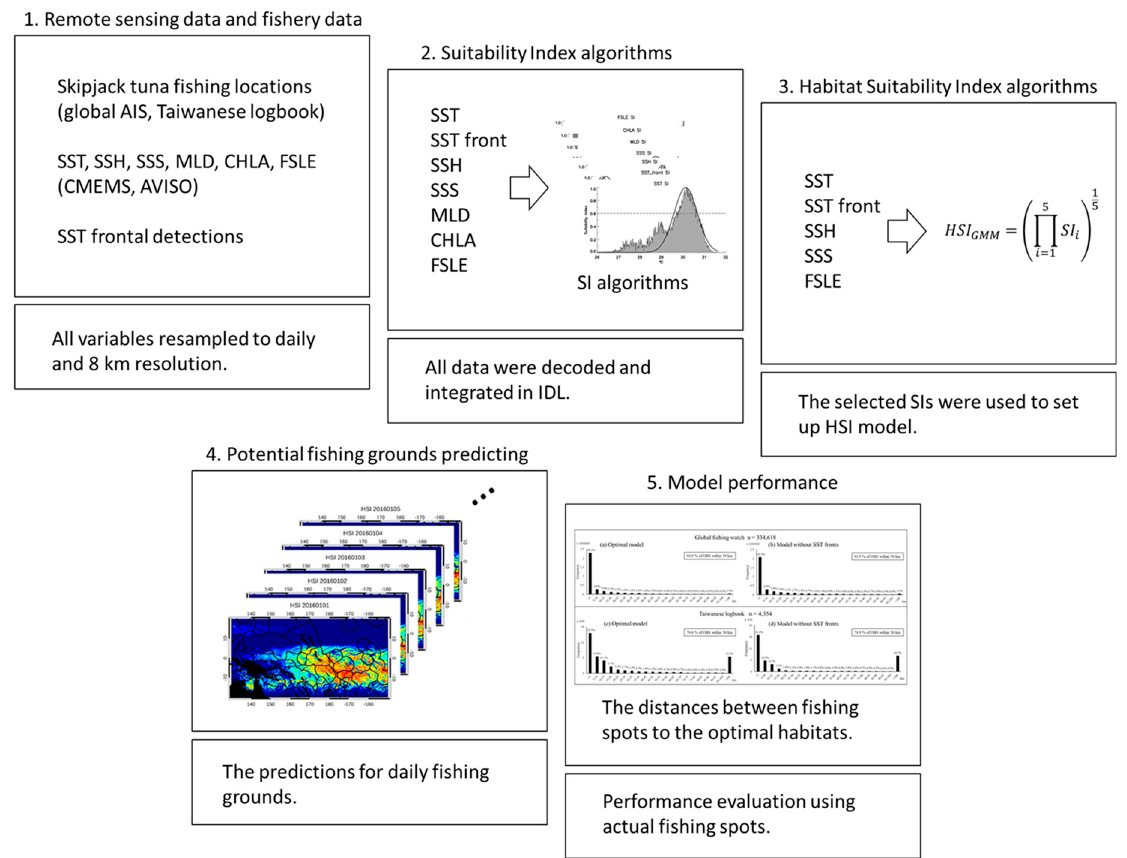
Figure 3. An illustration of workflow implemented for this study. The numbers are the step by step order.